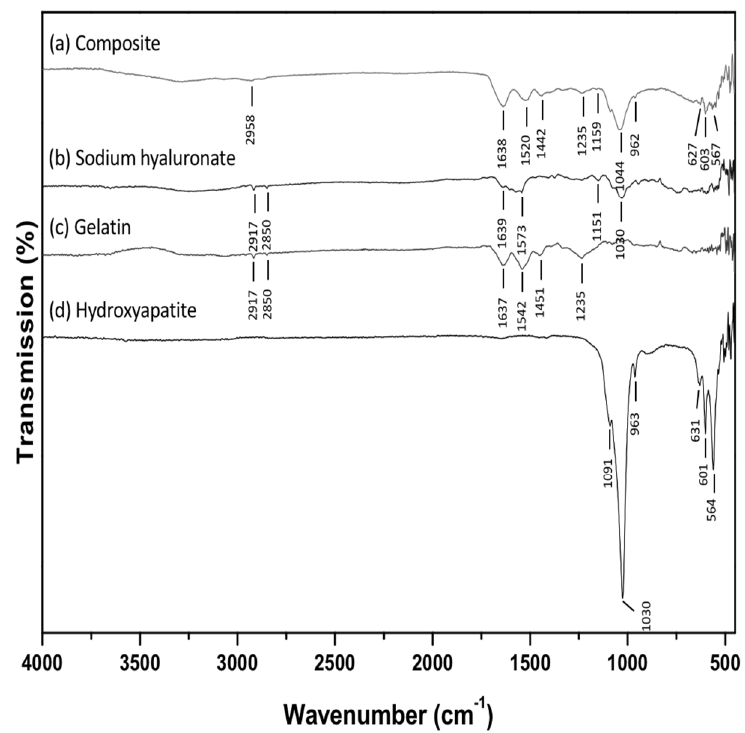
Figure 1. FTIR analysis. ( a ) The spectrum of Gel/HA–HAP composite, ( b ) sodium hyaluronate, ( c ) gelatin, and ( d ) hydroxyapatite. The shallow absorbance band representing the C–H bond stretching of BDDE is located at 2958 cm –1 , which indicates that hyaluronic acid and gelatin in the composite were crosslinked successfully.